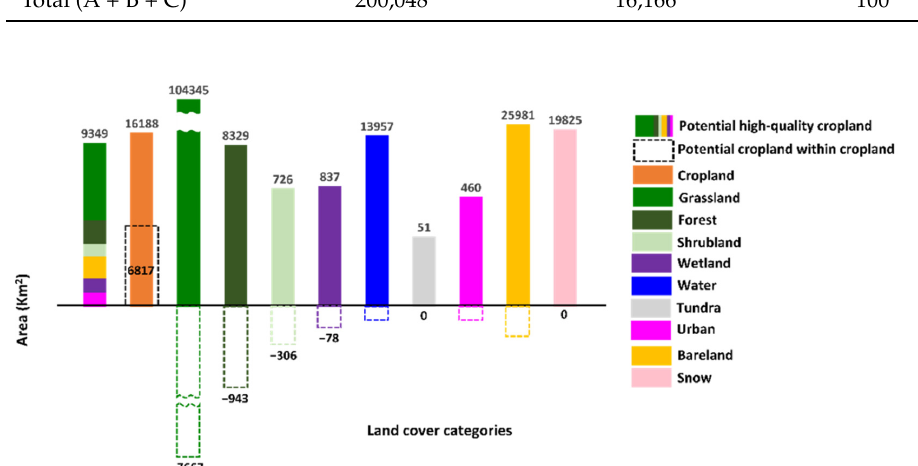
Figure 3. Composition of potential high-quality cropland by land use categories.